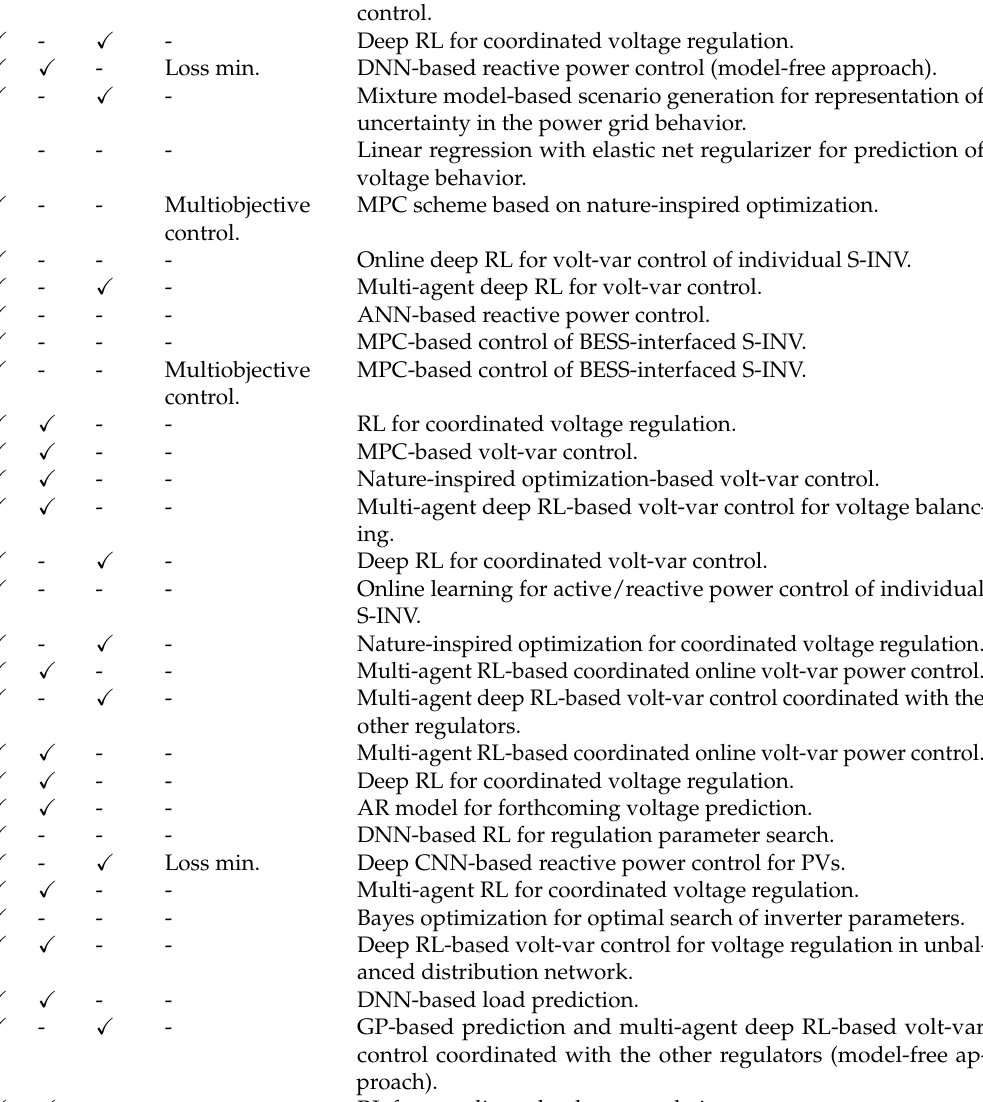
Linear regression for online game-theoretic coordinated volt-var control.